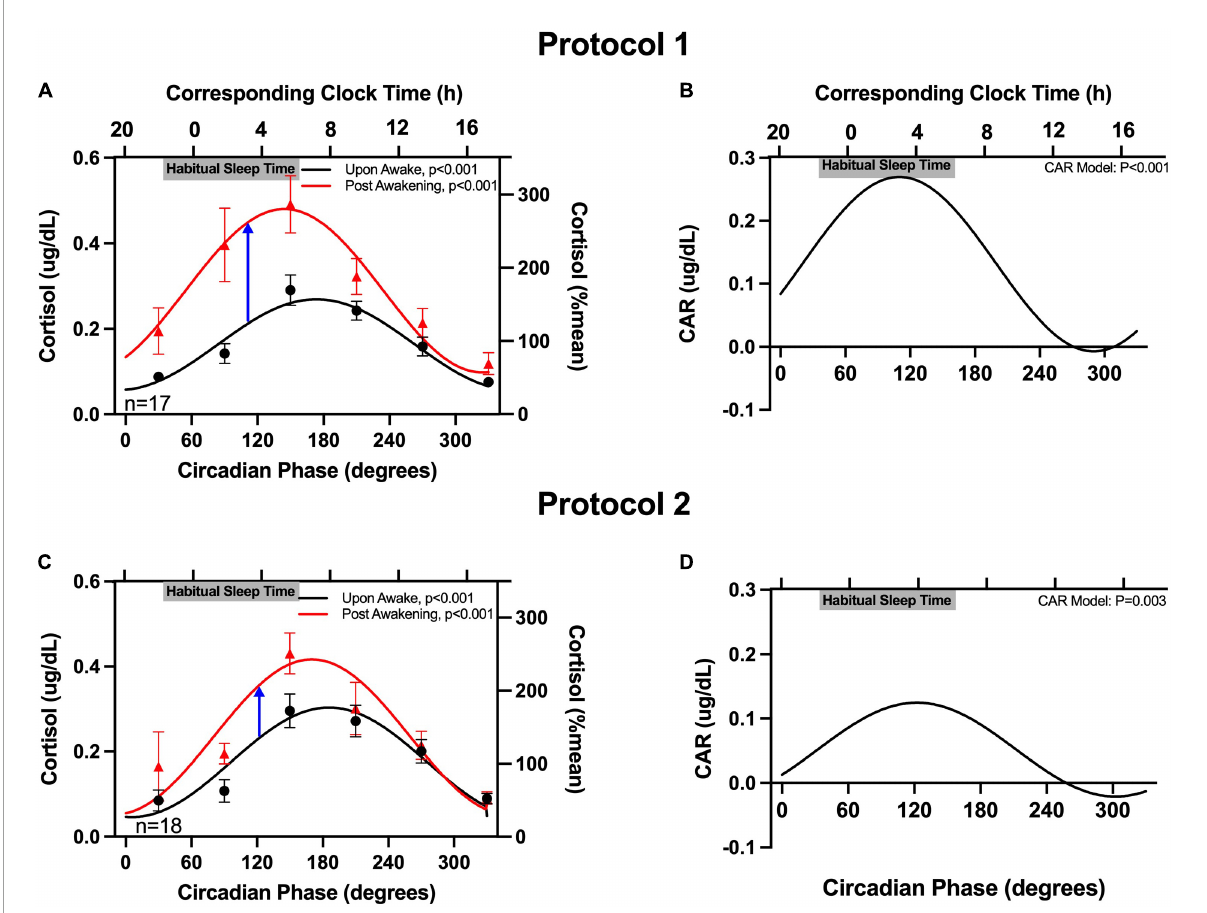
FIGURE2 Circadian rhythm in the cortisol awakening response (CAR). The cortisol concentrations upon-awakening and 50 min post-awakening as a function of circadian time are plotted on the left column (A,C) and the CAR is plotted on the right (B,D) . Data are expressed as absolute values (left y -axes) and as a percentage of the mean of each participant’s upon-awake values (right y -axes). Participants’ binned data (60 ◦ , 4-hour intervals, means ± SEM, left y -axes) are depicted as black circles (upon-awake) and red triangles (50 min post-awakening). Binned data were averaged within an individual first, as an individual could contribute more than one point to each bin. The solid lines represent the cosinor model fits. The blue arrows in (A,C) highlight the peaks of CAR in the two protocols. The corresponding clock times (determined from the average times of the DLMO for these participants) are shown on the top x -axes. Gray bars also on the top x -axes indicate the participants’ average habitual sleep times (determined from the at home